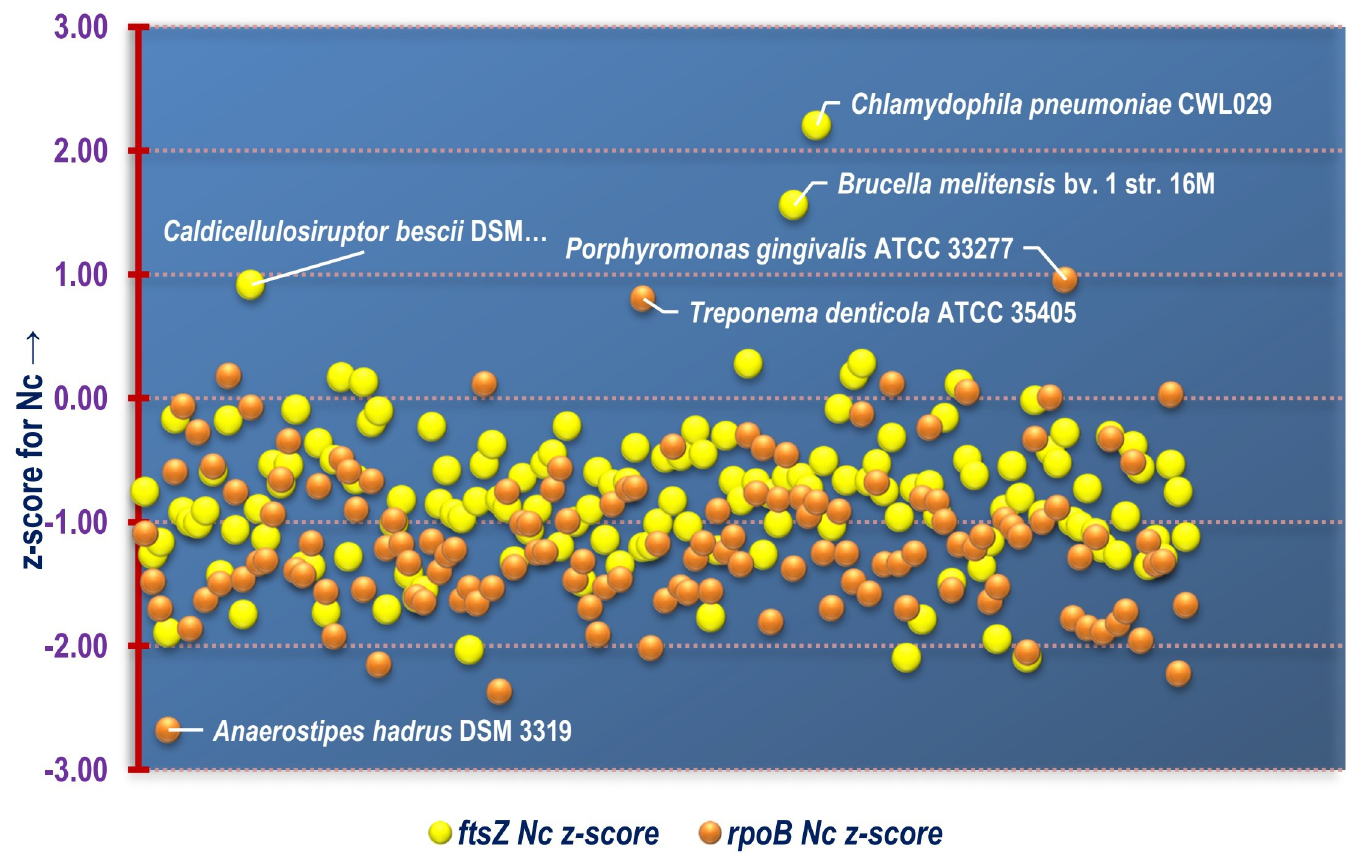
Fig 6. A scatter plot depicting the distribution of z-score for the Nc of ftsZ and rpoB CDS of all the bacterial species included in this study. The name of the organisms with relatively higher and lower Nc z-score have been labelled in the plot.